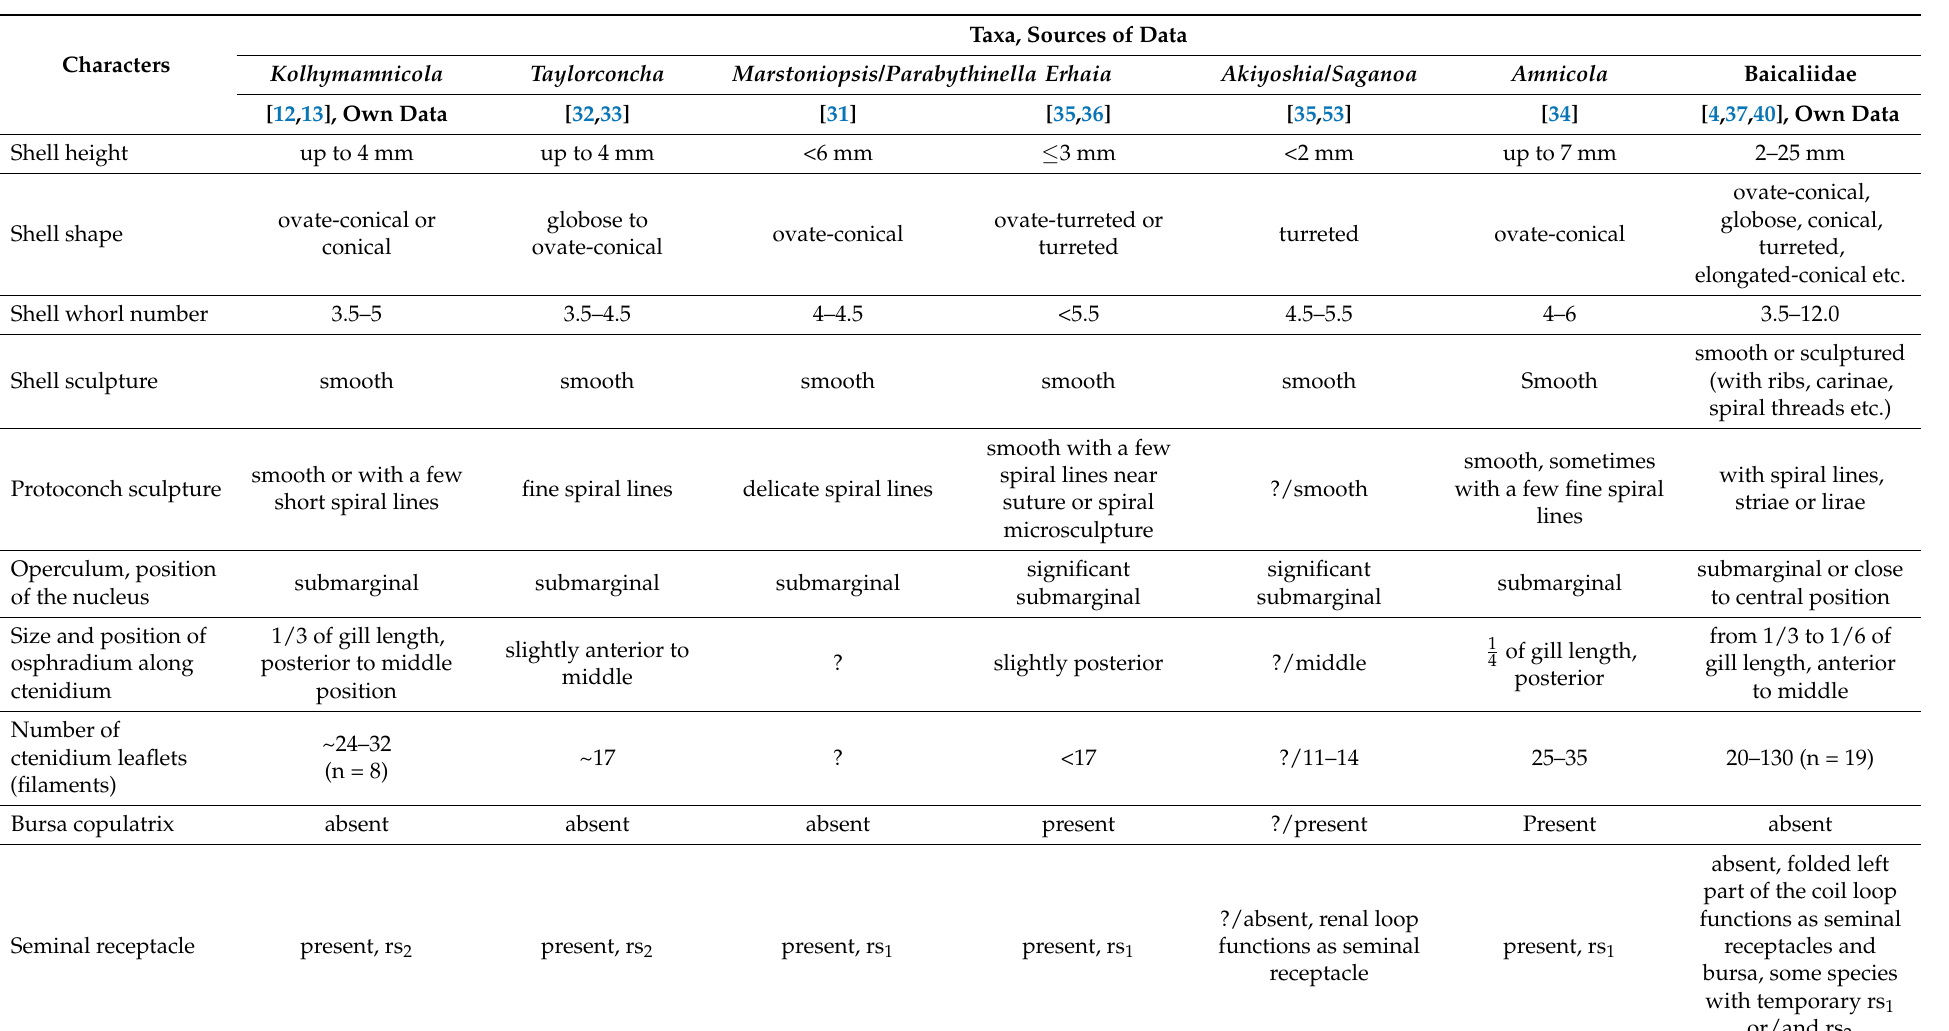
Table 4. Comparative morphological characteristics of the genera Kolhymamnicola, Taylorconcha, Erchaia, Marstoniopsis, Amnicola and the family